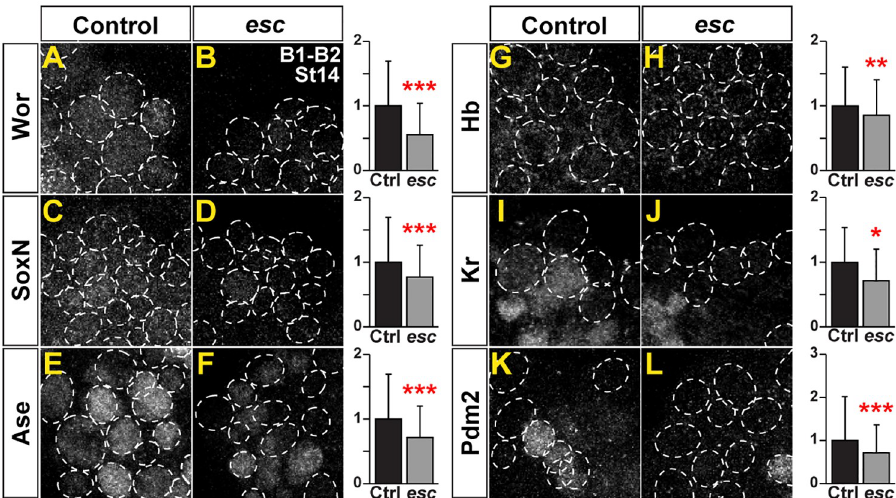
EF staining intensity in NBs, in control and esc maternal/zygotic mutants ( � p � 0.05, �� p � 0.01, ��� p � 0.001, Student two-tailed t test; n = 3 CNSs: n � 300 NBs; ± SD). All six EFs are significantly down-regulated in esc mutants. The numerical data underlying this figure are included in S1 Data. Genotypes: (A, C, E, G, I, K) OregonR . (B, D, F, H, J, L) esc 5 or esc 21 over esc Df ( Df(2L)Exel6030 ). esc 5 / esc 21 females crossed to esc Df males. Ase, Asense; CNS, central nervous system; Ctrl, control; Dpn, Deadpan; EF, Early Factor; esc , extra sex combs ; Hb, Hunchback; Kr, Kruppel; NB, neuroblast; Pdm, POU domain; PRC2, Polycomb Repressor Complex 2; SoxN, SoxNeuro; St, Stage; Wor,